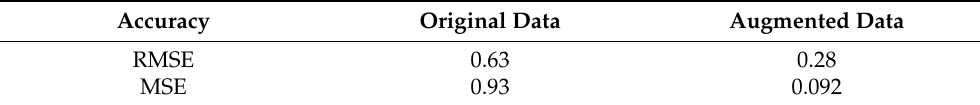
Table 2. Accuracy results of the XGBoost model when trained with original or augmented data. Accuracy Original Data